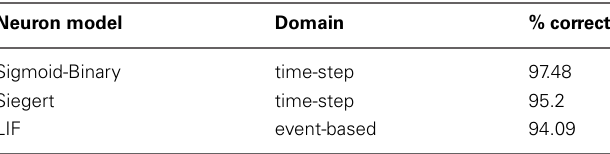
FIGURE 4 | Analysis of weights learned in the DBN. Visualization of the weights learned by a subset of neurons in the Visual Abstraction Layer for 28 × 28 images in the MNIST task. Each image shows the vector of weights feeding into one neuron. Table 2 | Classification performance on the MNIST test set for two time-stepped and one event-based LIF neuron model.